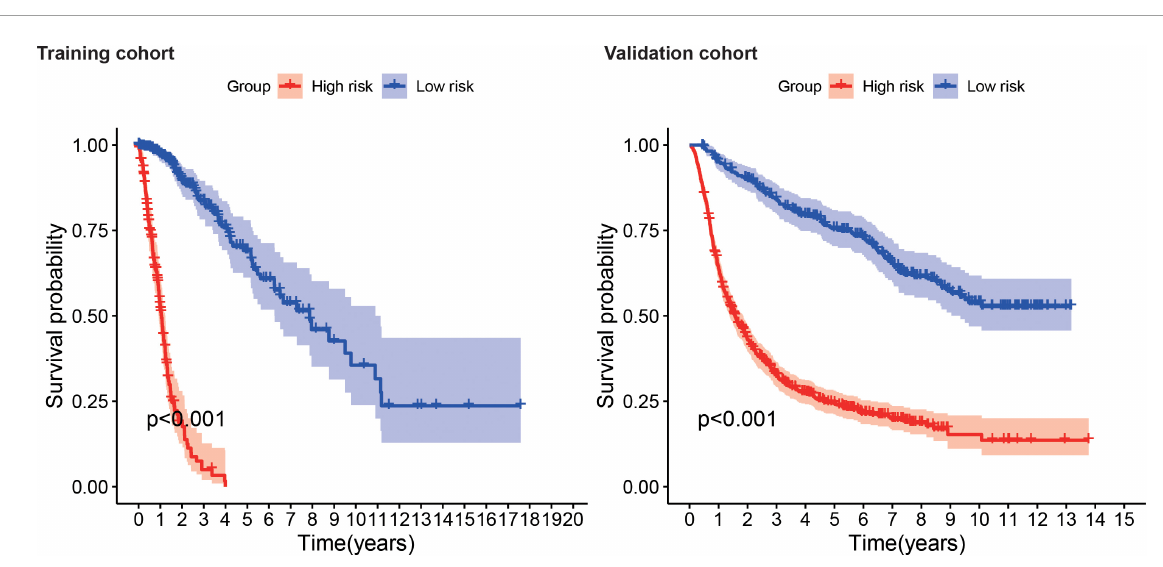
most abundant cellular component (CC) terminology included autolysosome, secondary lysosome, basal plasma membrane, basal part of cell, secretory granule membrane, and endocytic vesicle membrane ( Figure 9A ). The most abundant molecule function (MF) terms were ferric iron binding, ferrous iron